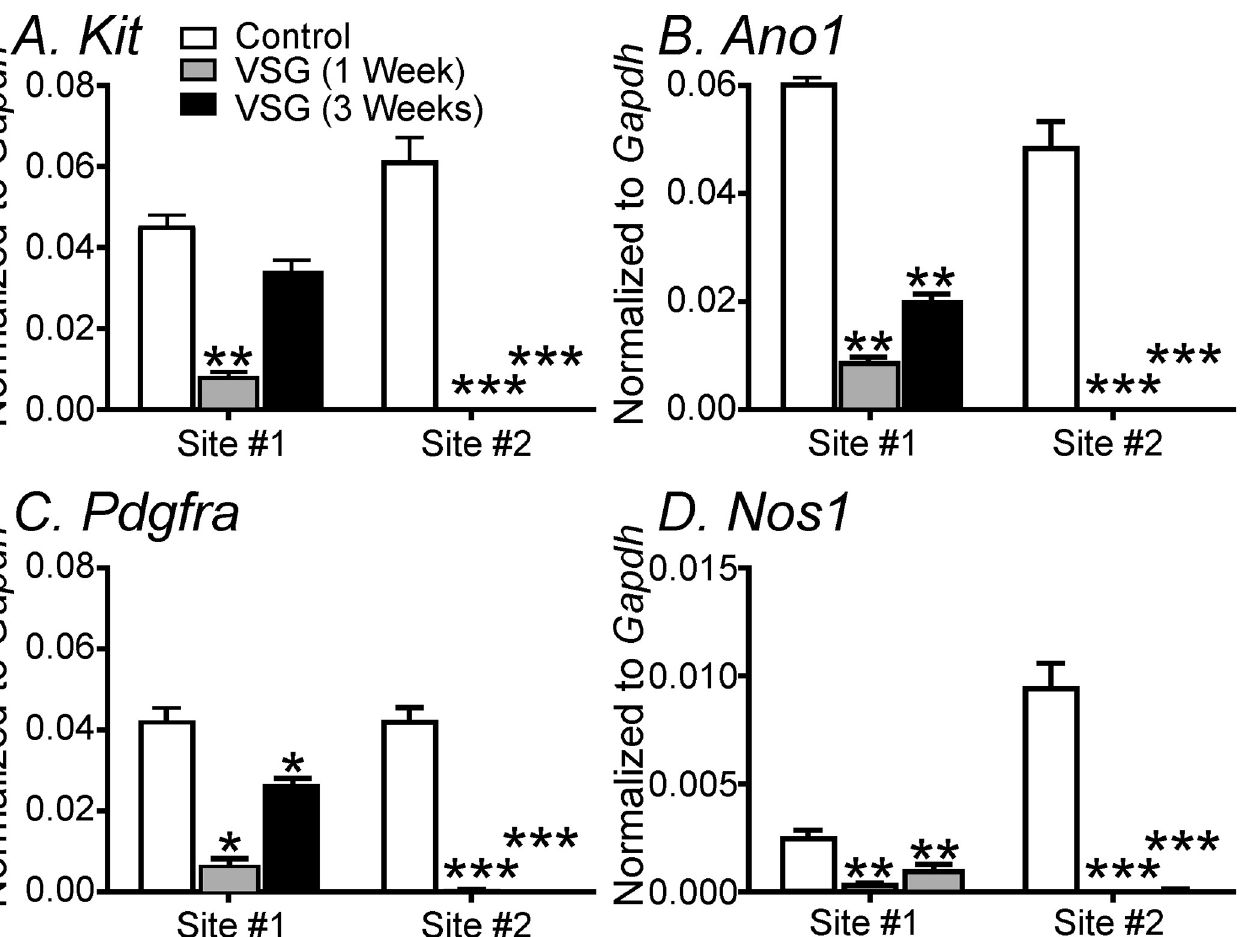
Fig 11. Comparison of changes in expression of gene transcripts in antum versus corpus in gastric tissues post-VSG. Panels A-D, Transcript expression of Kit , Ano1 , Pdgfra , and Nos1 genes at sites #1 and #2, 1- and 3- weeks post-VSG, respectively. At site #1, all cell-specific genes were significantly downregulated by 1 week and had shown only a partial recovery by 3 weeks. All of the gene transcripts that were examined at site #2 were downregulated, to a level that the expression was negligible, and these did not recover by 3 weeks ( �� P < 0.01 and ��� P < 0.001 for all